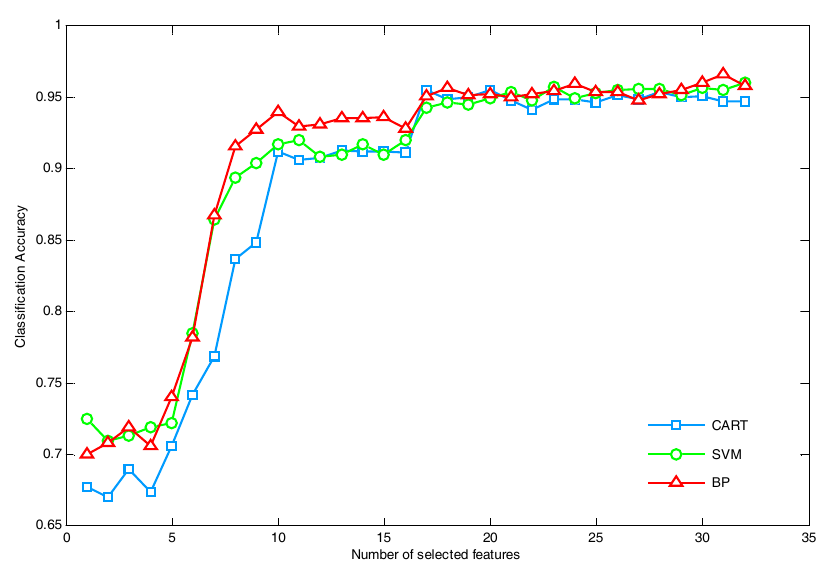
Figure 5. Variation of accuracies of with different number of selected features (NES39).